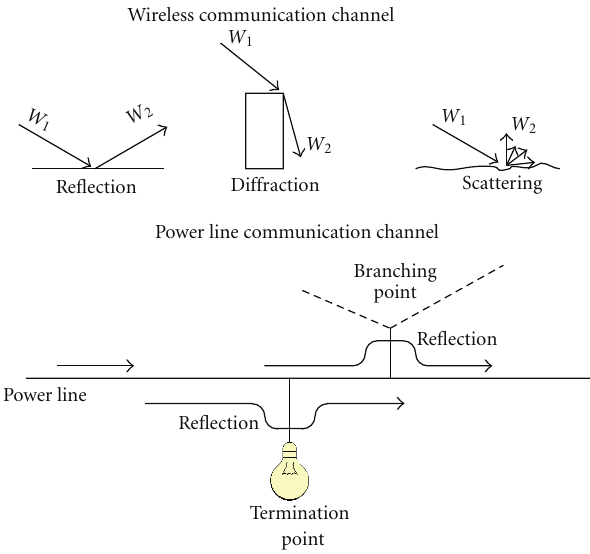
Figure 2: Propagation mechanisms for wireless and PLC channels.